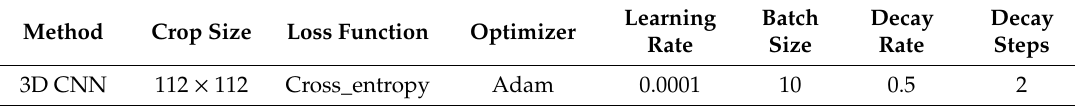
Table 1. 3D CNN parameter